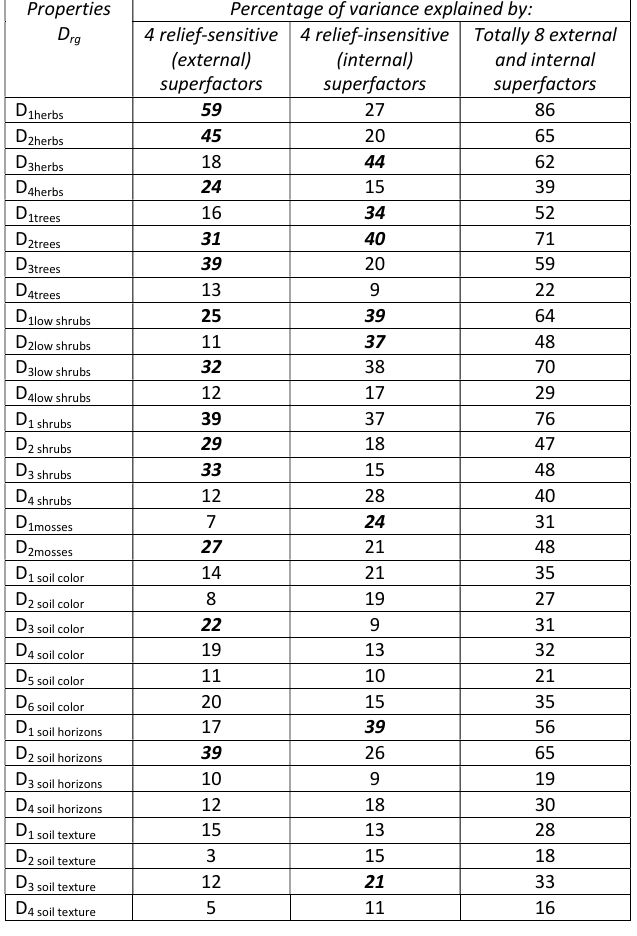
Table 1: Contributions of the external and internal effects on spatial variability of geocomponents properties Drg (where r – rank, g – geocomponent) expressed by axes of multidimensional scaling (NMDS). Bold italic letters – significant